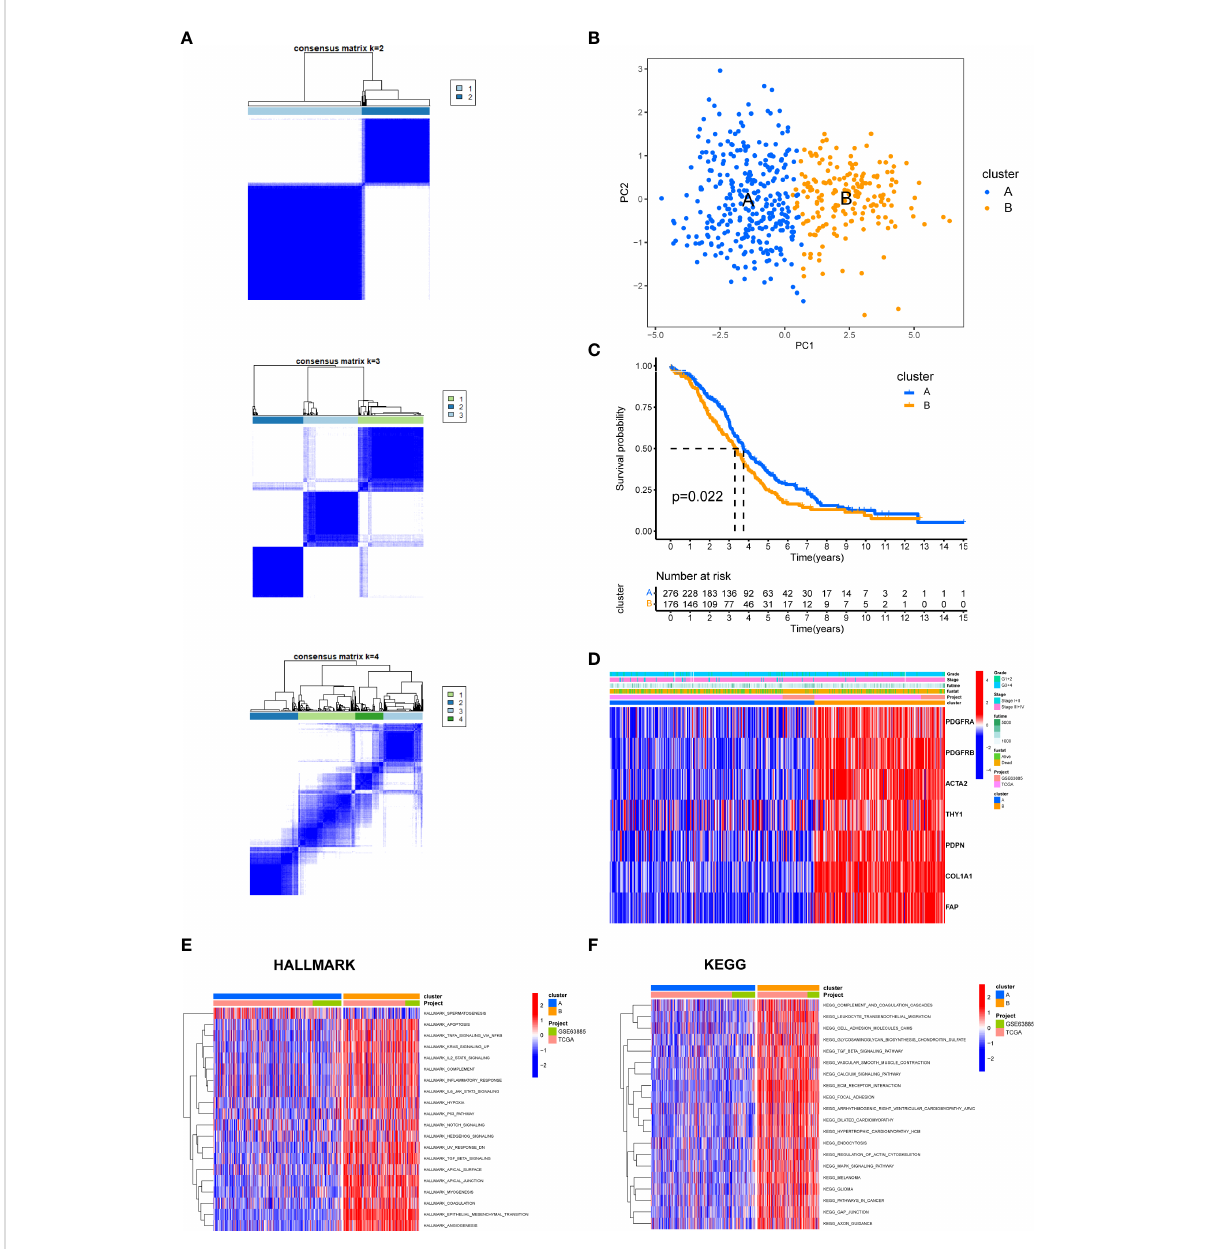
FIGURE 9 The biological characteristics between two CAF subtypes in the EOC cohort. (A) Two clusters (k = 2) were identi fi ed by consistent clustering. (B) The transcriptomes of the two CAF subtypes differed signi fi cantly. (C) Kaplan – Meier curves of overall survival between cluster A and B. (D) The heat map depicted the relationship between the expression of CAF markers and clinical characteristics of two CAF subtypes. (E) HALLMARK pathways between two CAF subtypes. (F) KEGG pathways between two CAF subtypes. The red and blue colors represent pathways that are active and inhibitory,